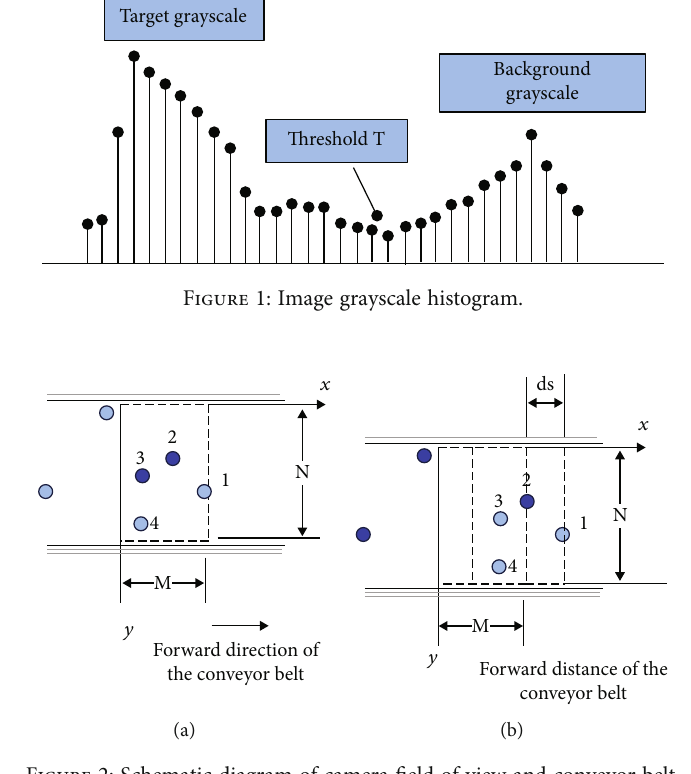
Figure 2: Schematic diagram of camera fi eld of view and conveyor belt.